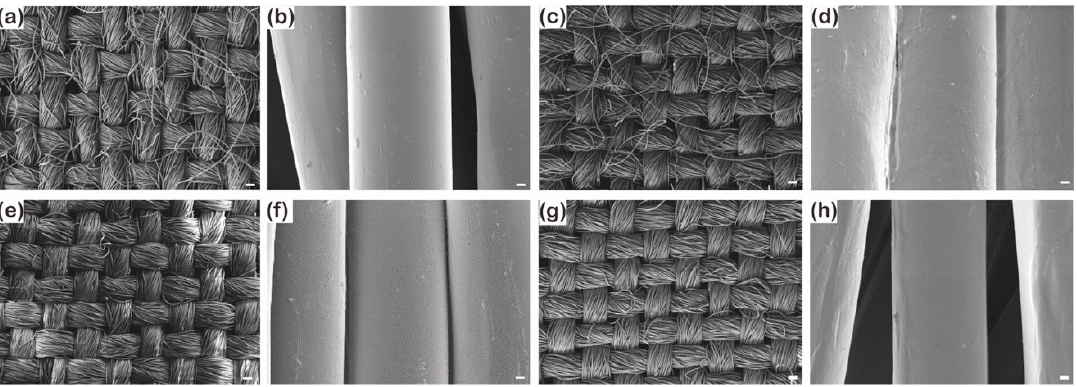
Figure 1. SEM images of untreated ( a , b ) and P1T1 PDMS-coated ( c , d ) staple fabrics, untreated ( e , f ) and P1T1 PDMS-coated ( g , h ) filament fabrics. (magnification: ×100 and scale bar: 200 μ m and magnification: ×10,000 and scale bar: 2 μ m).